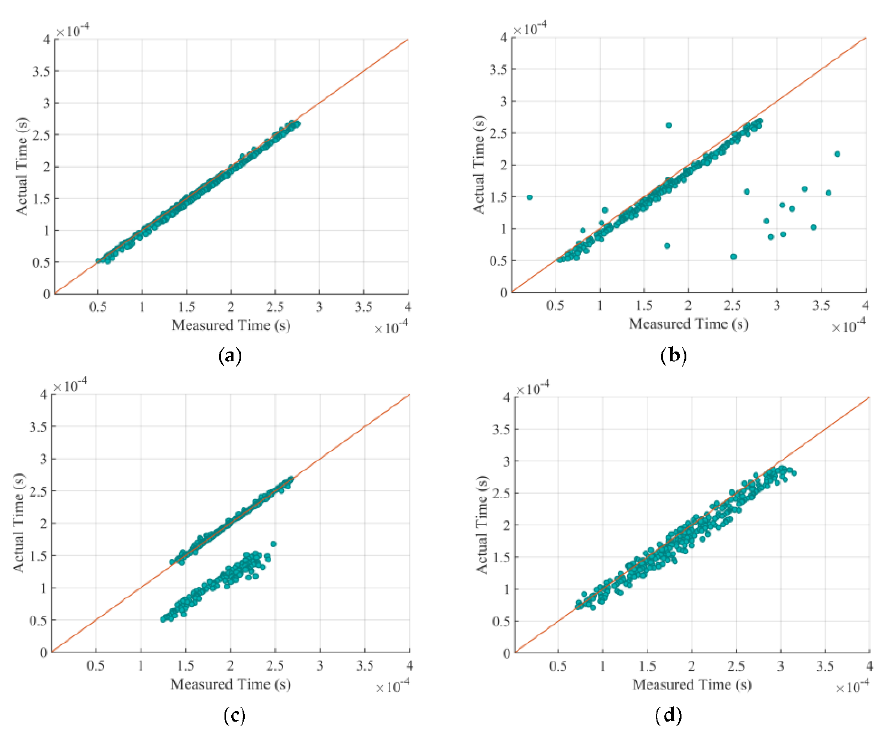
Figure 6. Distribution of measured values and the corresponding actual values on 15dB: ( a ) proposed; ( b ) Short-term Average over Long-term Average (STA/LTA); ( c ) Akaike information criterion (AIC); ( d ) Teager-Kaiser energy operator (TKEO).